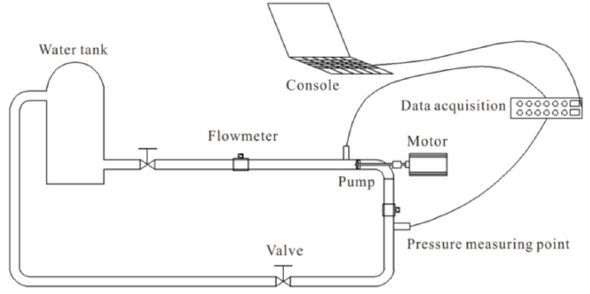
Figure 3. The experimental diagram. Table 2. Comparison of numerical simulation and experimental results. Flow